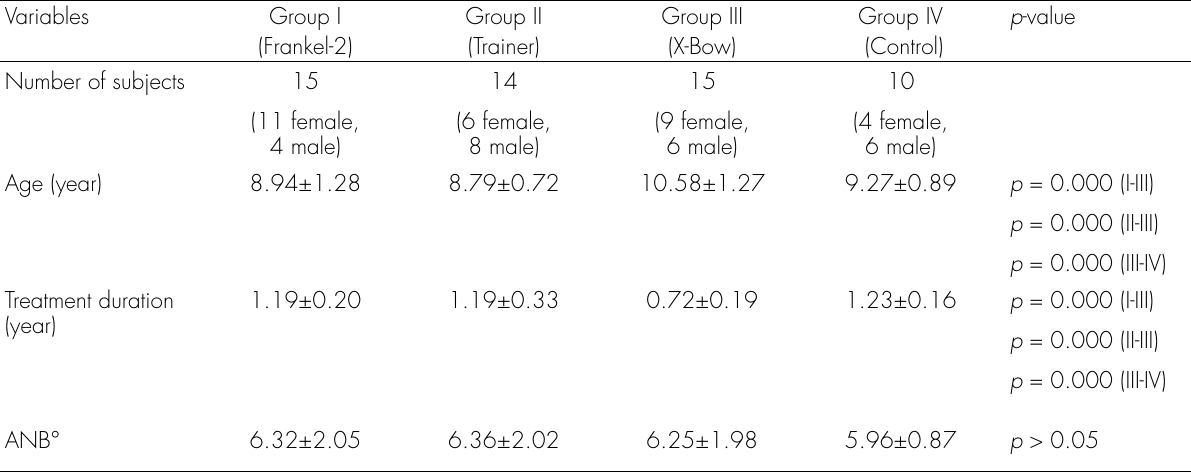
Parametric one-way variance analysis (ANOVA) and LSD analysis Values are presented as mean ± standard deviation (SD) or p-